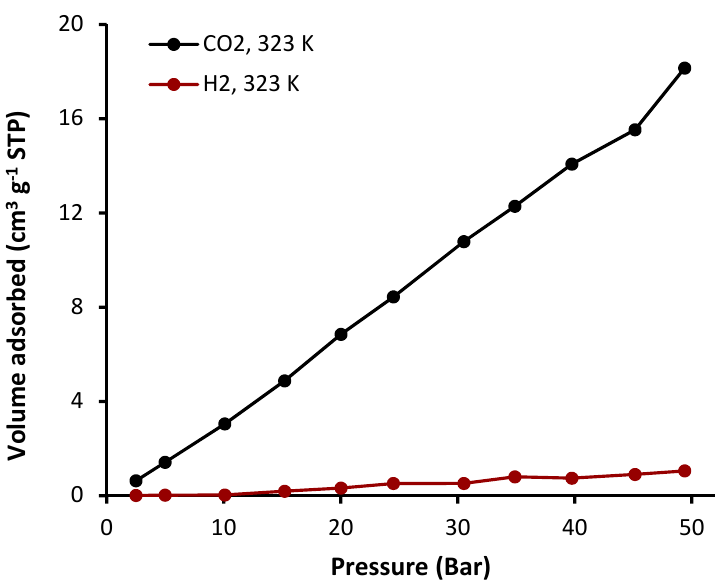
Figure 8. Adsorption isotherms of CO 2 and H 2 for complex 1 .